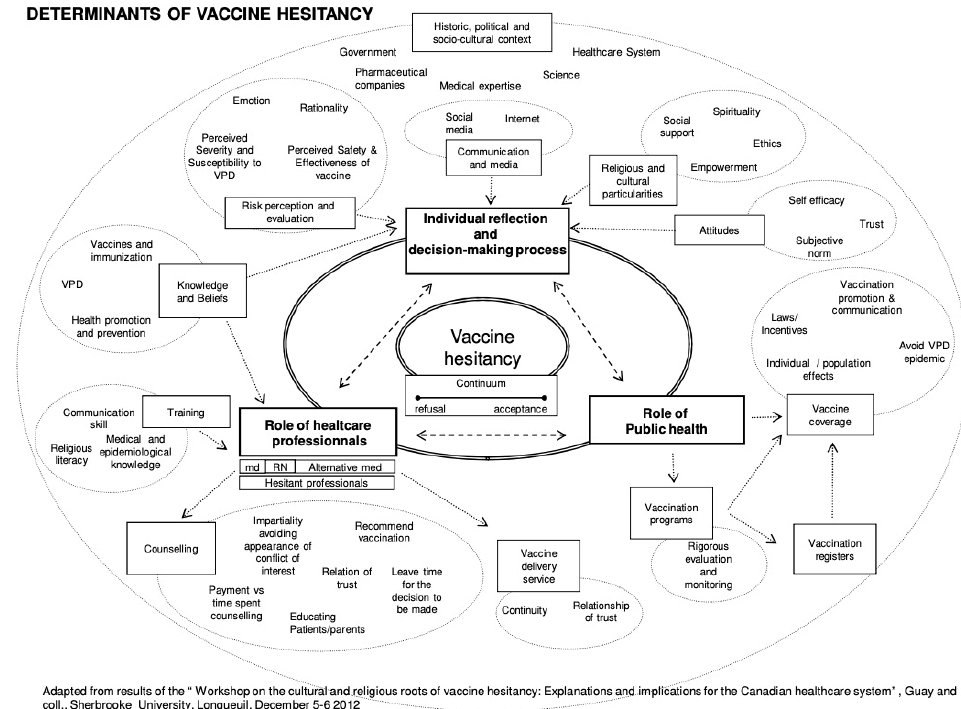
Figure 2. The Vaccine Hesitancy Determinants Model (2011) [7].